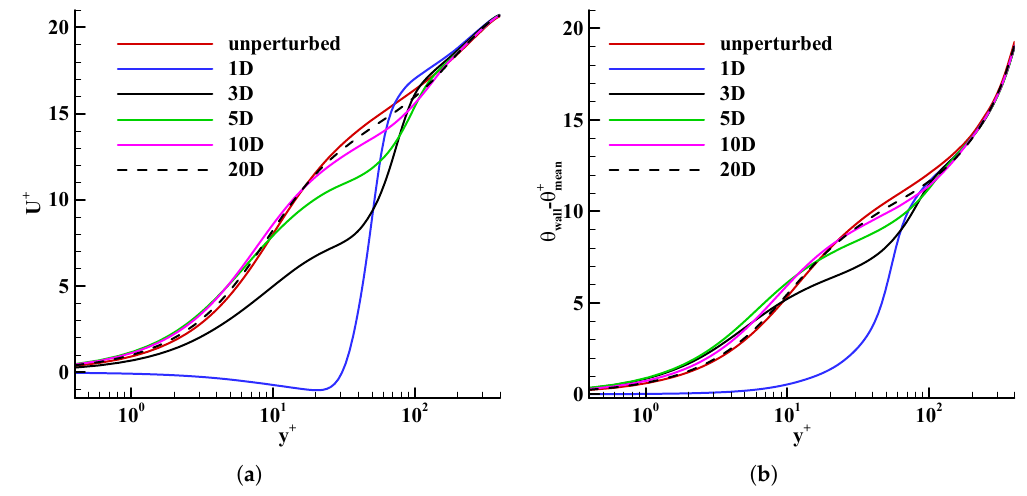
Figure 2. ( a ) Mean streamwise velocity variation and ( b ) mean temperature variation in the wall normal direction behind the